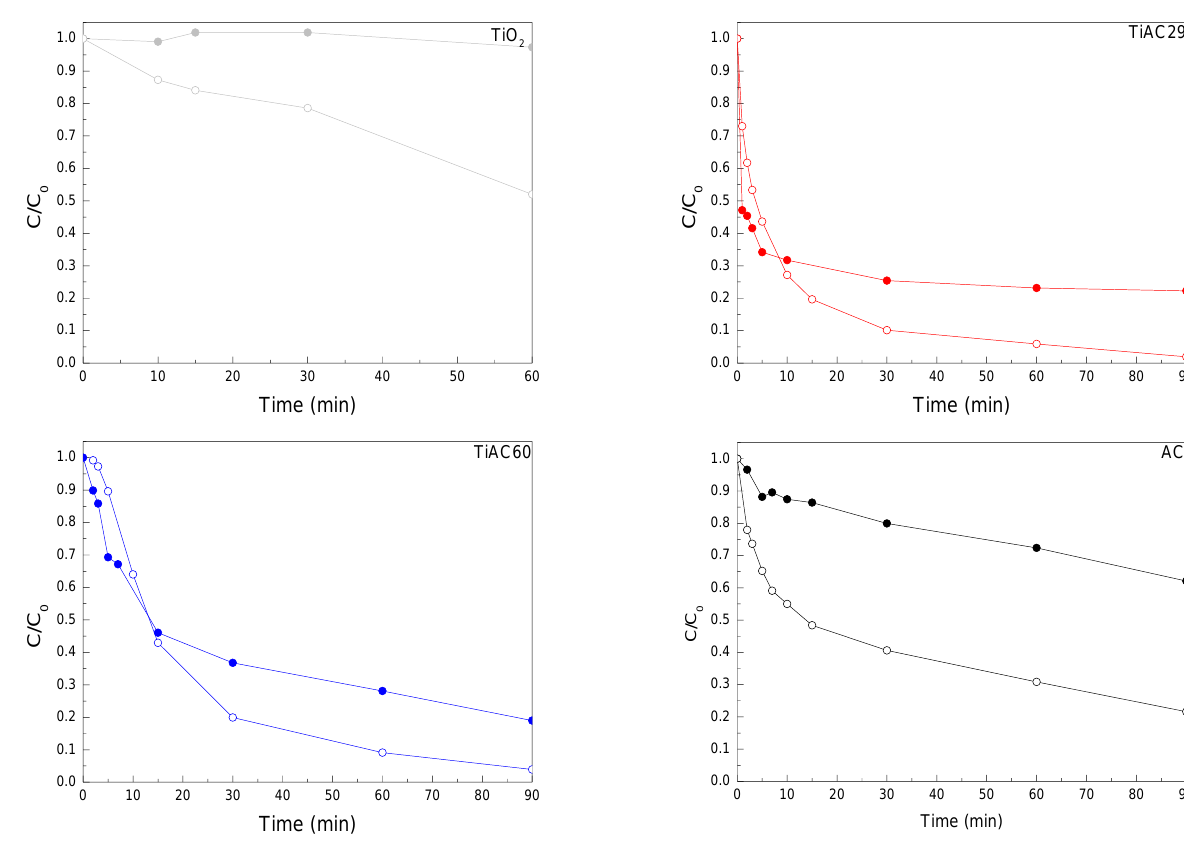
Figure 11. Comparison of MB adsorption (filled symbols) and solution discolouration by combined adsorption+photocatalysis under simulated solar light irradiation (open symbols) over bare materials and composites. Table 5. Kinetic data from combined adsorption+photocatalytic MB removal from ultra-pure water (a) . Photocatalyst